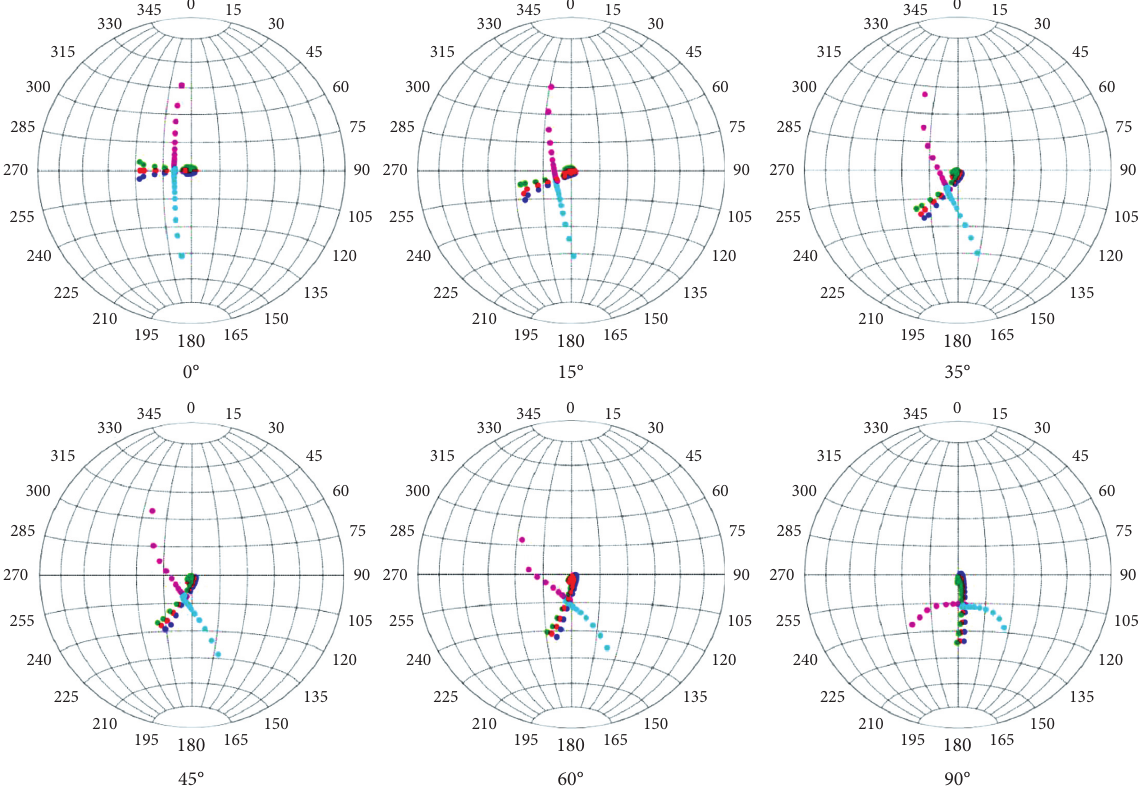
Figure 10: Rotation trajectory characteristics of maximum principal stress under different advancing